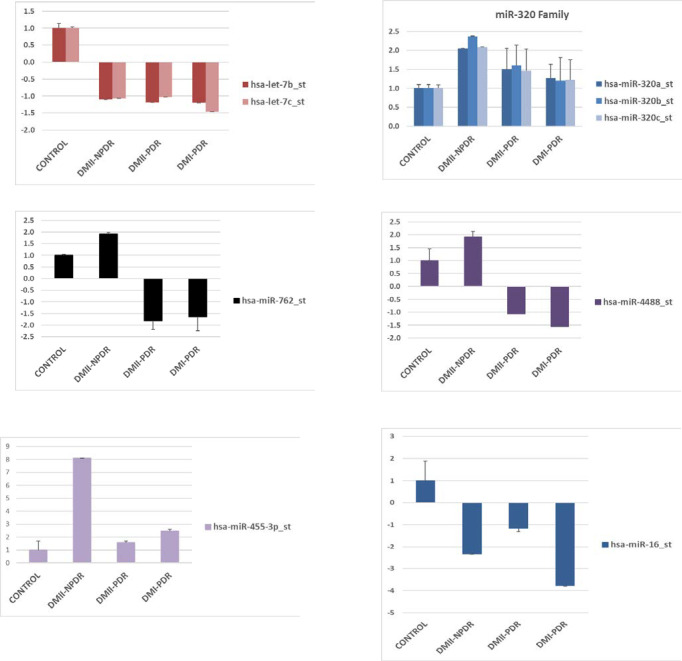
Select set of differentially expressed miRNA in plasma in DRI-PDR, DRII-PDR and DRII-NPDR.